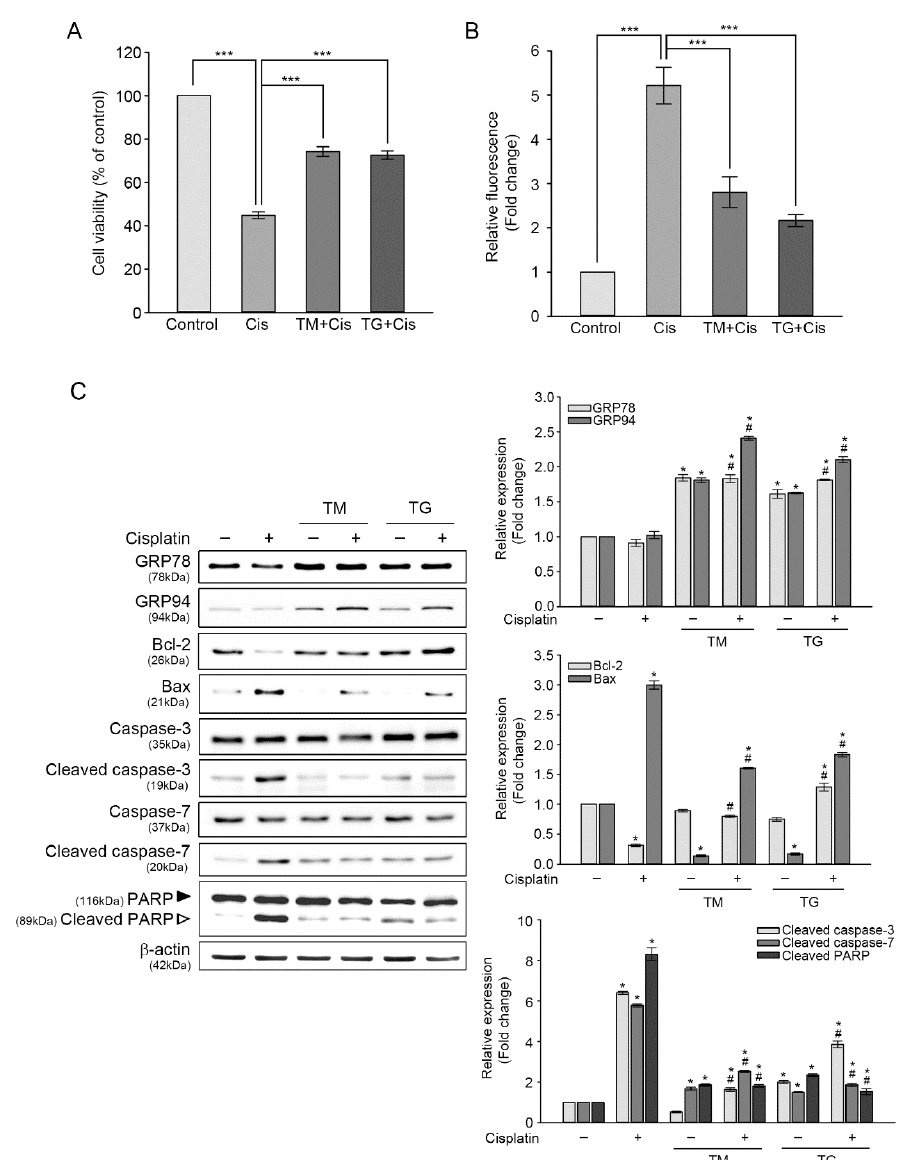
Figure 3. Protective effect of GRP78 and GRP94 induction on cisplatin-mediated cytotoxicity. ( A ) Cells were pretreated with 0.1 μg/mL of TM or 3 nM of TG or for 24 h and then treated with 25 μM of cisplatin for another 24 h. ( A ) Cell viability was measured through CCK assay. Values are expressed as means ± SE of four independent experiments, expressed as a percentage of untreated control values. *** p < 0.001, compared with untreated control. ( B ) ROS levels were determined through DCF fluorescence intensity spectrofluorometry. Values are expressed as means ± SE of three independent experiments. *** p < 0.001, compared with the untreated control. ( C ) Expressions of apoptosis-related proteins were analyzed through immunoblotting. β-actin was used as a control for protein loading. The graph represents relative protein levels compared with the untreated control after normalization to β-actin levels. Values are expressed as means ± SE of three independent experiments. * ,# p < 0.05, *; compared with the untreated control, # ; cisplatin-only versus TM plus cisplatin or TG plus cisplatin. Finally, the protective e ff ects of GRP overexpression on cisplatin-induced apoptosis was